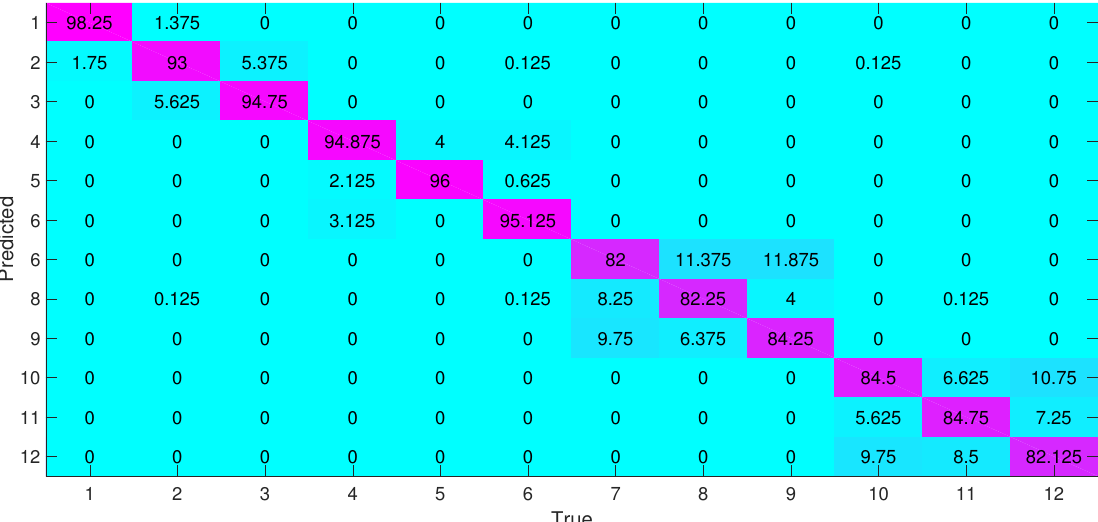
two cases: (a) when the unknown device is of the same model of some of the devices in the training set; in this case, the algorithm should predict that it is of a specific model, but not of the other models; (b) when the unknown device is of a different model from the models already present in the training set. In this case, the algorithm should determine that it is completely unknown. To implement the first case (a), we have first decreased the initial training set to 11 devices. Device 12 (i.e., an